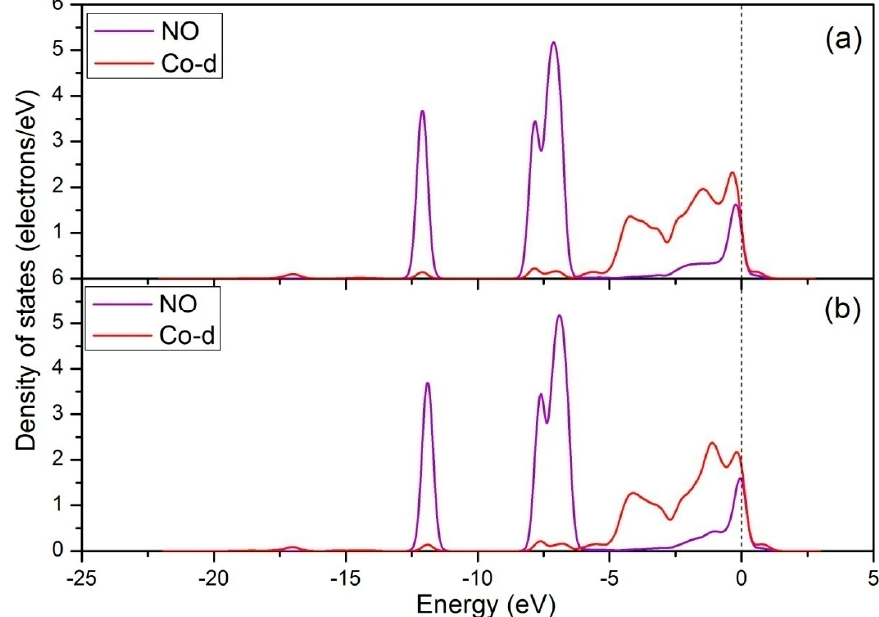
Figure 8. Density of states of the NO molecule and Co-d orbit: ( a ) For NO adsorption on the perfect CoO 2 -terminated LaCoO 3 (011) surface, ( b ) for NO adsorption on the Ce-doped CoO 2 -terminated LaCoO 3 (011) surface.